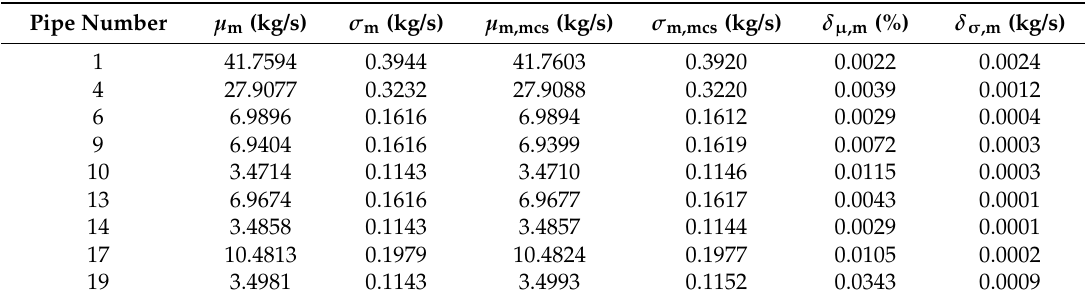
Table 1. Typical mean and standard deviations of mass flow rates. (Test 1: L = 300 m; µ ϕ = 0.5 MW; σ ϕ = ± 10%).